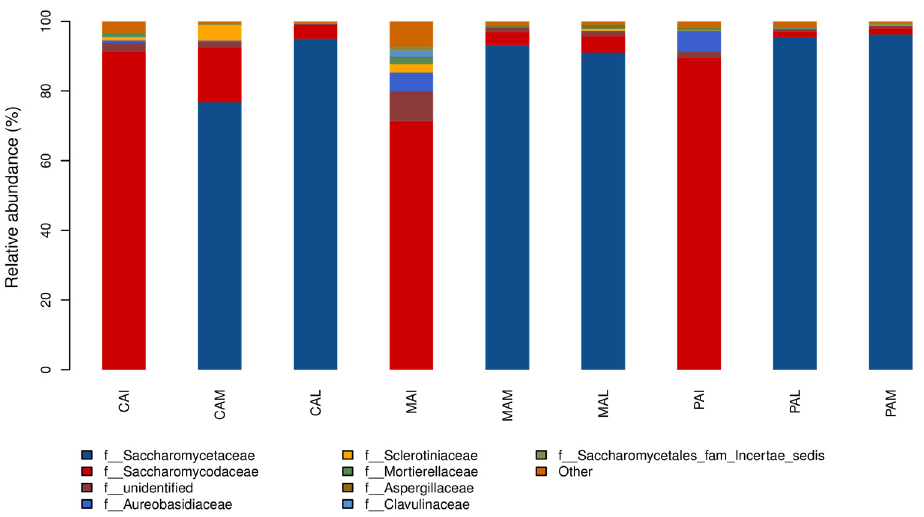
Figure 5. Histogram of species composition of family-level samples. CAI is the pre-fermentation Cabernet Sauvignon, CAM is the mid-fermentation Cabernet Sauvignon, and CAL is the late fer- mentation Cabernet Sauvignon. MAI is the pre-fermentation Matheran, MAM is the mid-fermenta- tion Matheran, and MAL is the late fermentation Matheran. PAI is the pre-fermentation Cabernet Franc, PAM is the mid-fermentation Cabernet Franc, and PAL is the late fermentation Cabernet Franc.